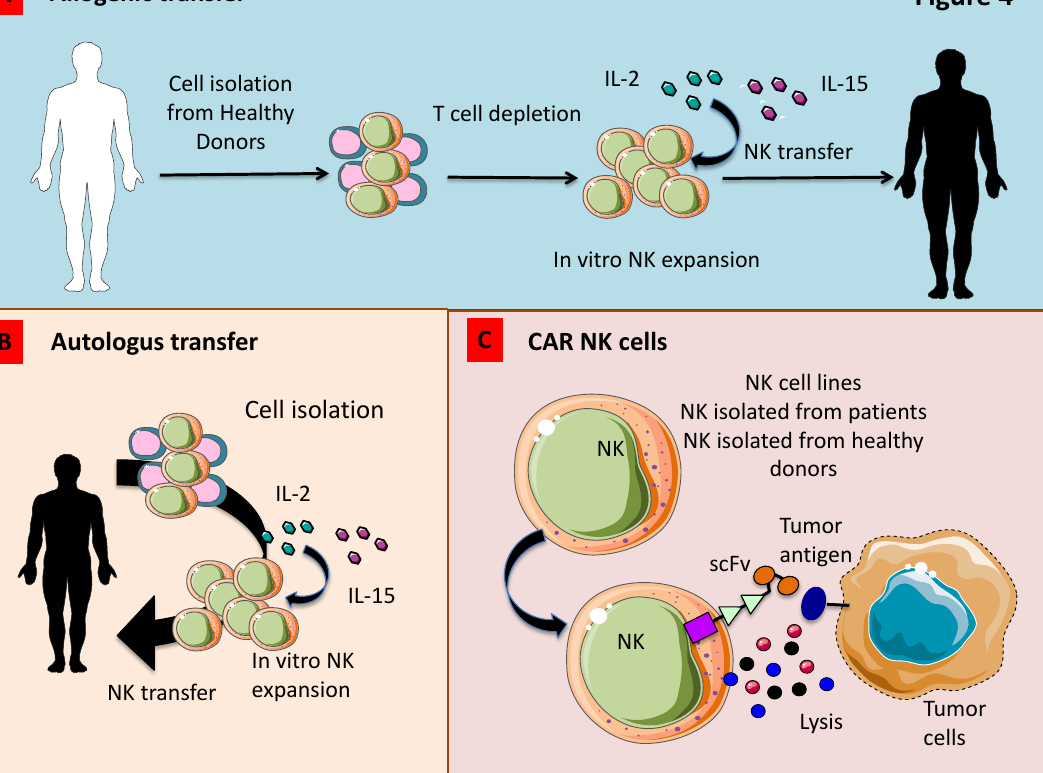
Figure 5. Strategies to increase the anti-tumor activity of adoptively transferred NK cells for anti-cancer therapy. ( A ) Allogenic NK cells expanded ex vivo with IL-2 and/or IL-15 show a strong anti-tumor effect in patients which do not express the HLA-I allele recognized by inhibitory HLA-I receptors present on donor NK cells. ( B ) Also, autologous NK cells expanded ex vivo can be used to kill tumor cells. ( C ) Novel tools such as Chimeric Antigen Receptors (CAR) transduced into NK cells isolated from either healthy donors or patients can trigger transferred-NK cells to kill tumor cells. To avoid the variability of the NK cell activity from donor to donor, some NK cell lines have been transduced with CAR and used in clinical